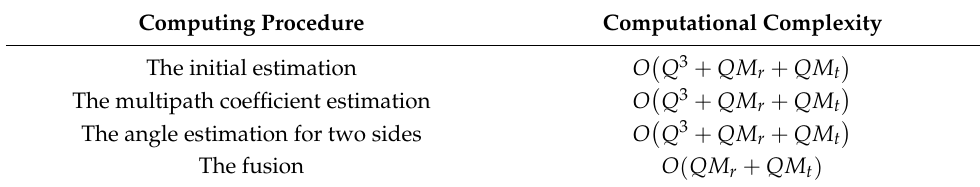
Table 2. Computational complexity of the BSC algorithm.